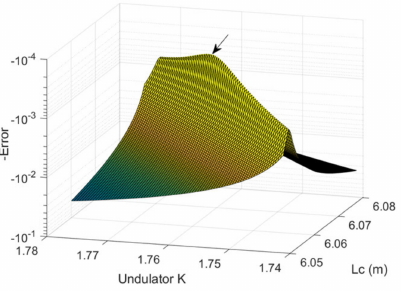
Figure 10. The minimum error search by varying Lc and K u at K = 1.7411 for the phase-shifter No. 5. The invert of the error is depicted to show the minimum clearly. The arrow indicates the minimum error point ( K = 1.7581 and Lc = 6.0671 m).